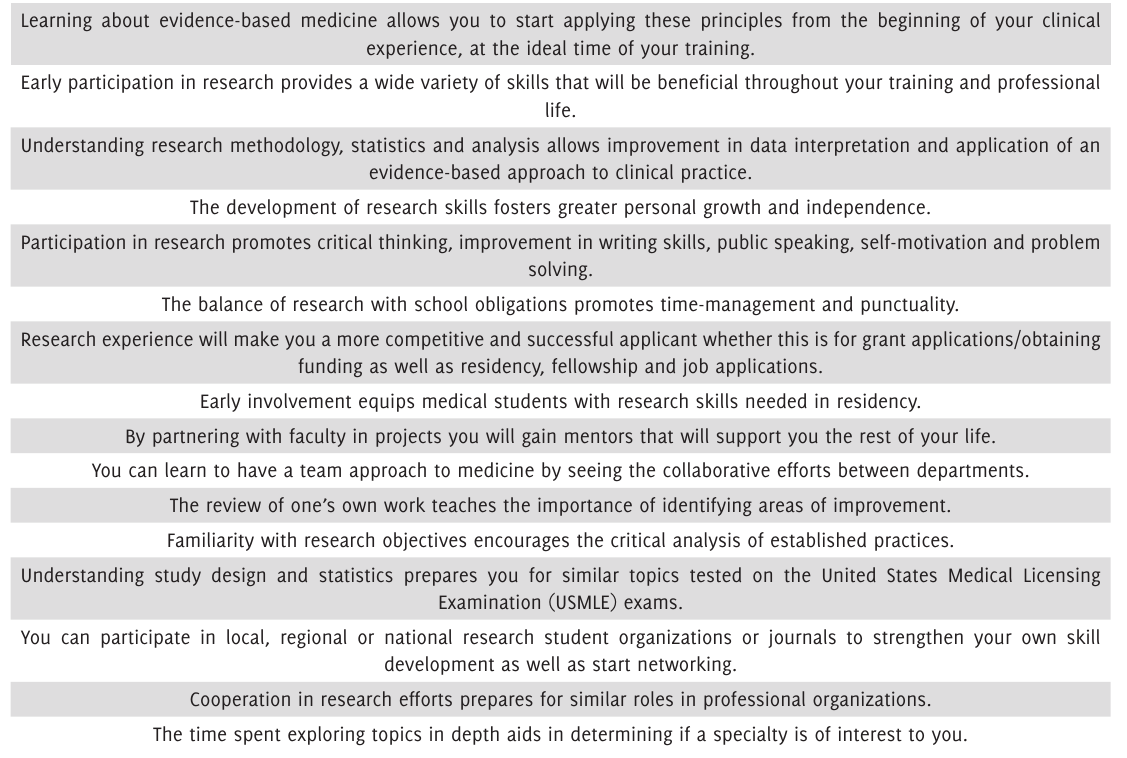
Table 2. Translation to Practice: Suggested applications of the information provided to your medical student